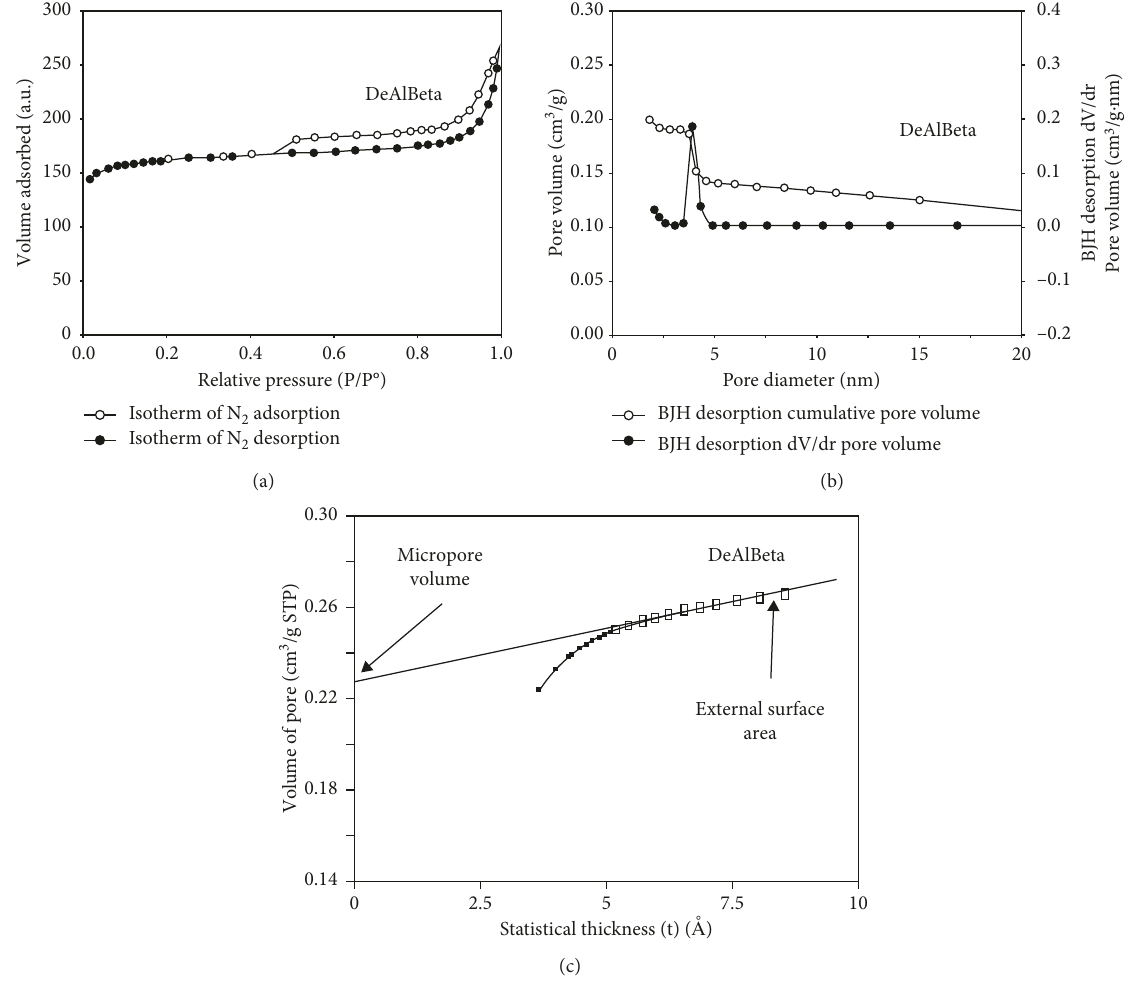
Figure 2: The plots for the DeAlBeta sample: (a) N 2 adsorption-desorption isotherm; (b) BJH pore size distribution; (c)